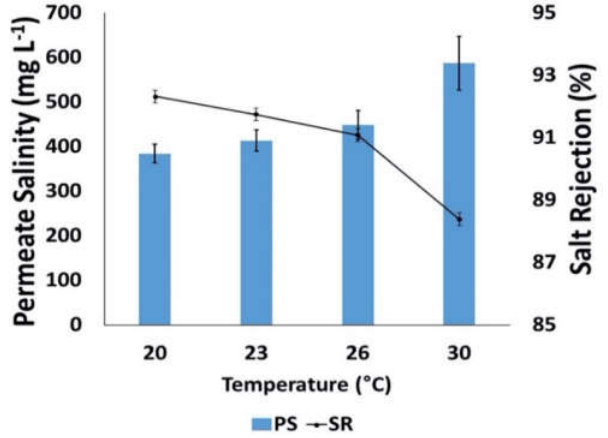
Figure 5. Permeate salinity and salt rejection.